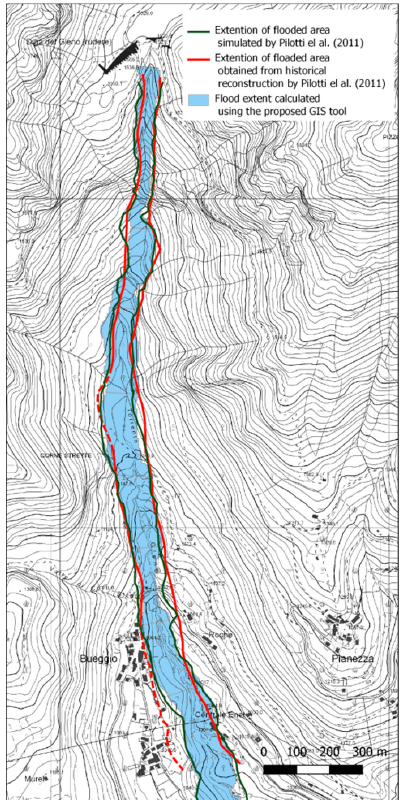
Figure 12. Comparison of the flooded area estimated by the proposed GIS tool for the first 2.3 km of the Gleno Dam-break with the flooded area (i) simulated by the hydrodynamic model and (ii) obtained from historical reconstruction both by Pilotti at al. [36]. Table 3. Results of the GIS tool performance in terms of the flooded area compared respectively with the results simulated by the hydrodynamic model of Pilotti et al. [36] and obtained from historical reconstruction by Pilotti et al. [36] for the Gleno dam-break case study.